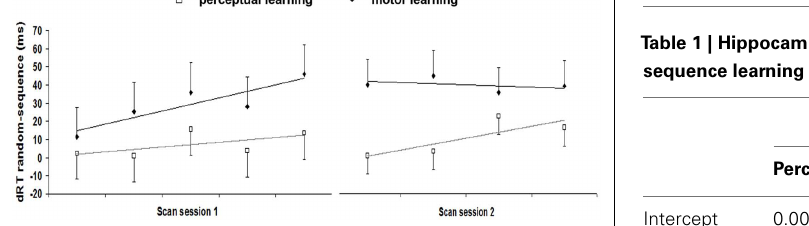
FIGURE 6 | Random minus sequence RT difference scores (dRTs) reflecting sequence learning effects for each block of scanning session 1 and 2 (old sequence) for implicit perceptual and motor sequence learning. Error bars represent 95% confidence intervals.